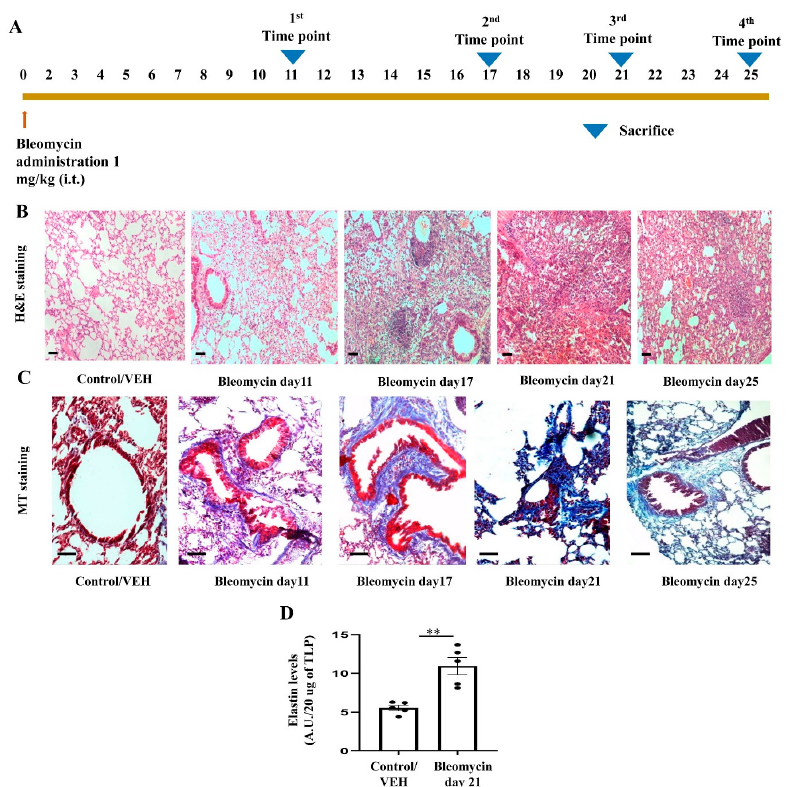
Figure 7. Development of mice model of bleomycin-induced pulmonary fibrosis ( A ) Experimental protocol for developing mice model of pulmonary fibrosis. ( B ) H & E staining (bars = 100 µm) showing the morphology of lungs from control and bleomycin-treated mice. ( C ) MT staining (bars = 100 µm) depicting collagen deposition in lungs of control and bleomycin-treated mice. ( D ) Elastin assay in total lung lysate from control and bleomycin-treated mice. ** p = 0.003.